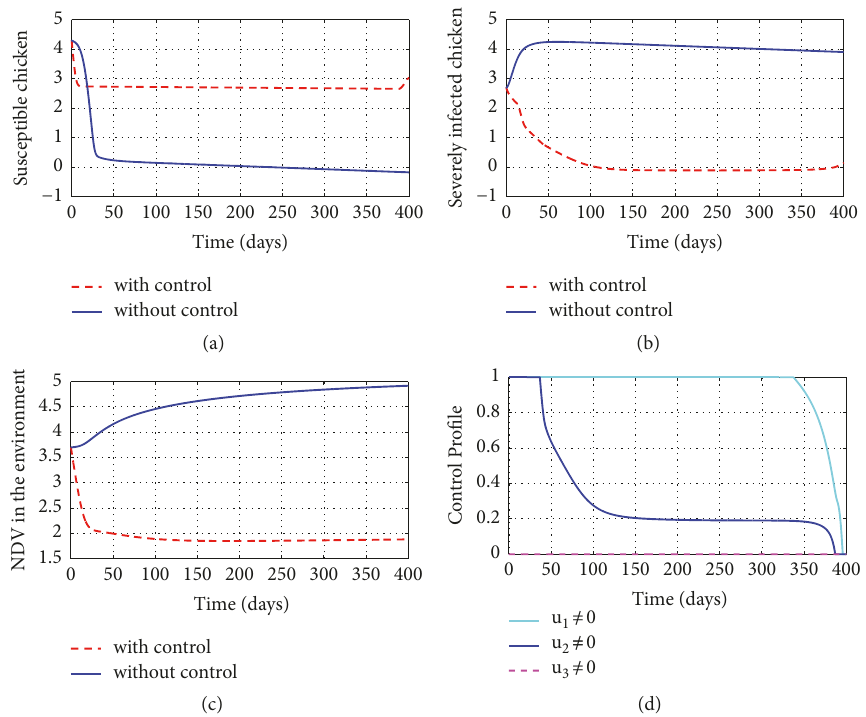
Figure 7: Optimal solutions for model variables 𝑆 𝑐 , 𝐼 𝑐 , 𝐻 and the control profiles for 𝑢 1 , 𝑢 2 , 𝑢 3 with ( 𝑢 1 ̸= 0 , 𝑢 2 ̸= 0 , 𝑢 3 ̸= 0 ).